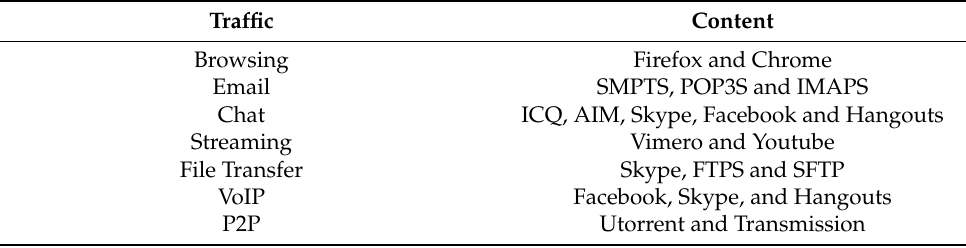
Table 1. The traffic classes and traffic content.